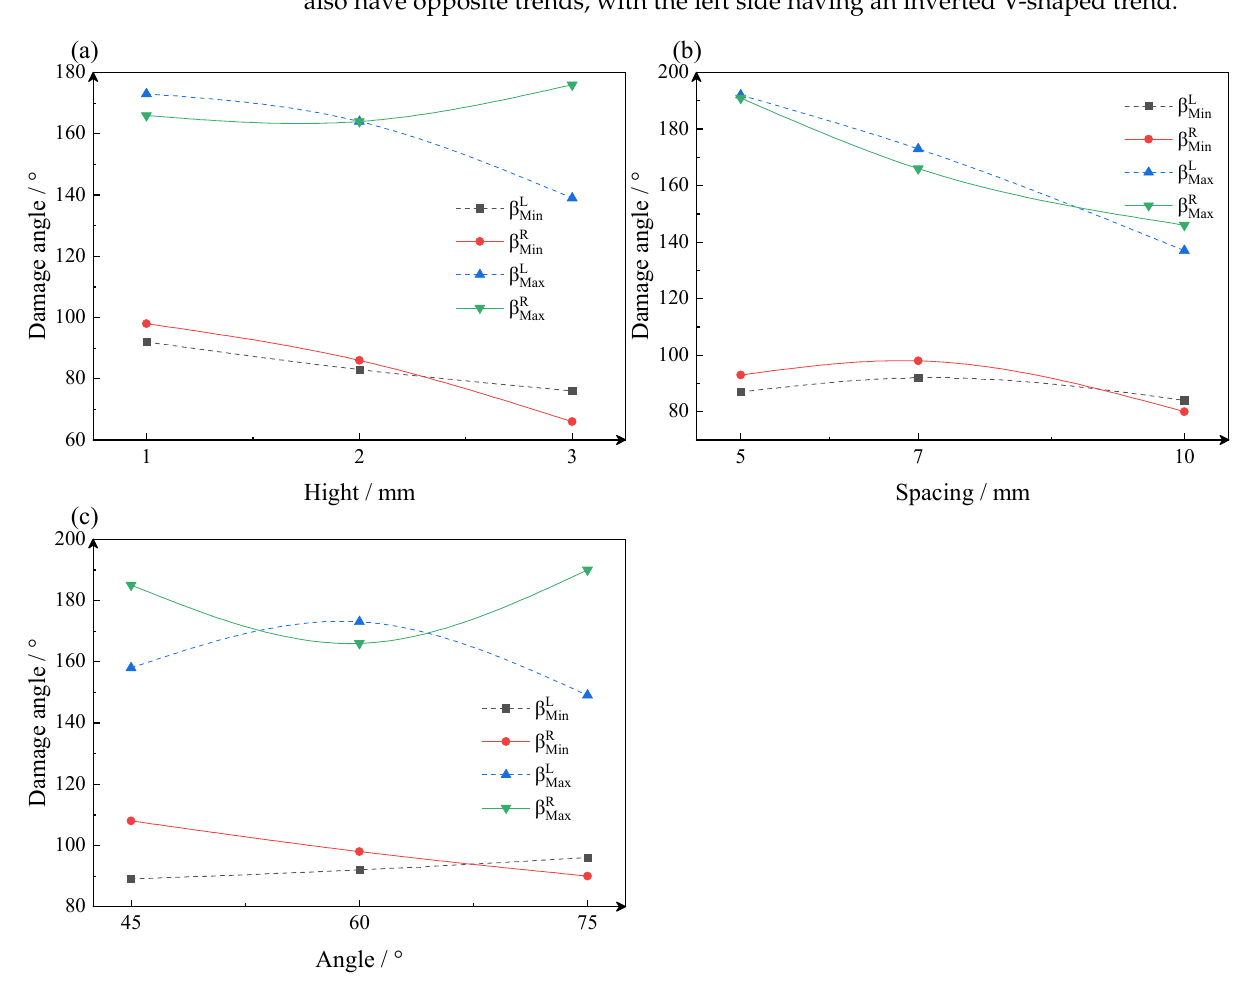
Figure 12. Analysis of damage angles: ( a ) heights ( b ) spacing ( c ) angles.